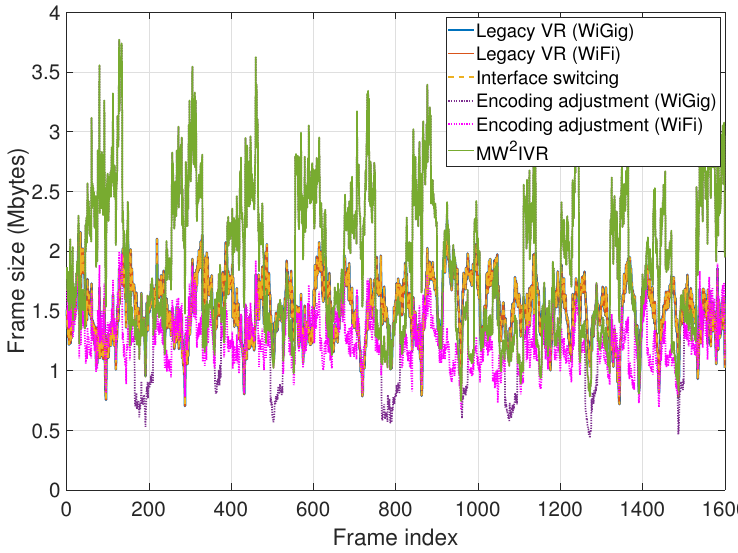
Figure 12. Generated and delivered frame sizes over